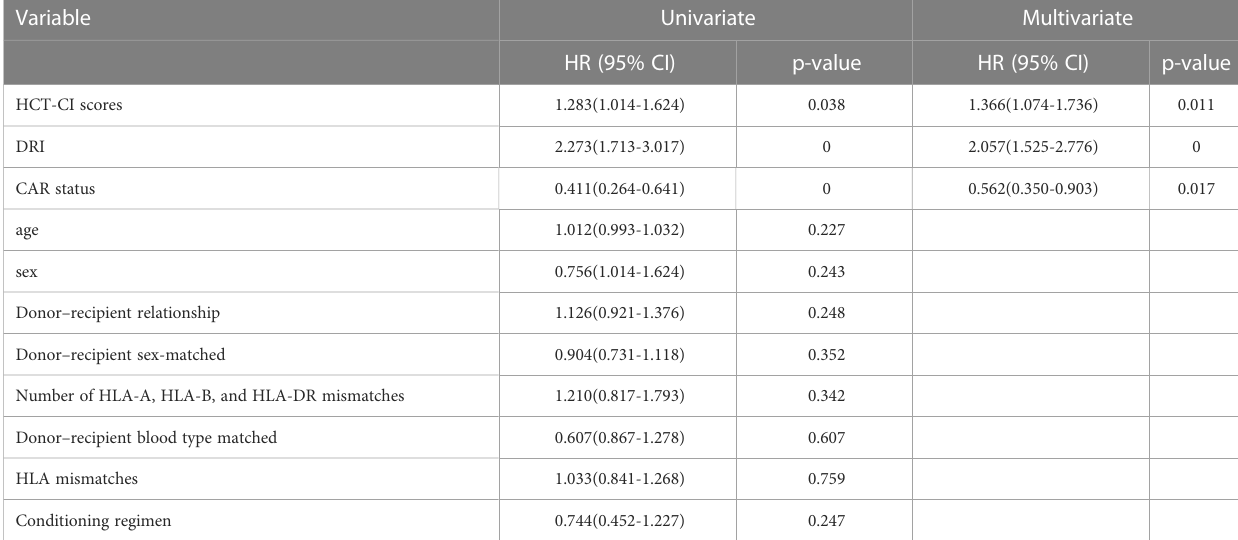
TABLE 3 Univariate and multivariate Cox analysis for OS in patients with haplo-HSCT in training cohort.